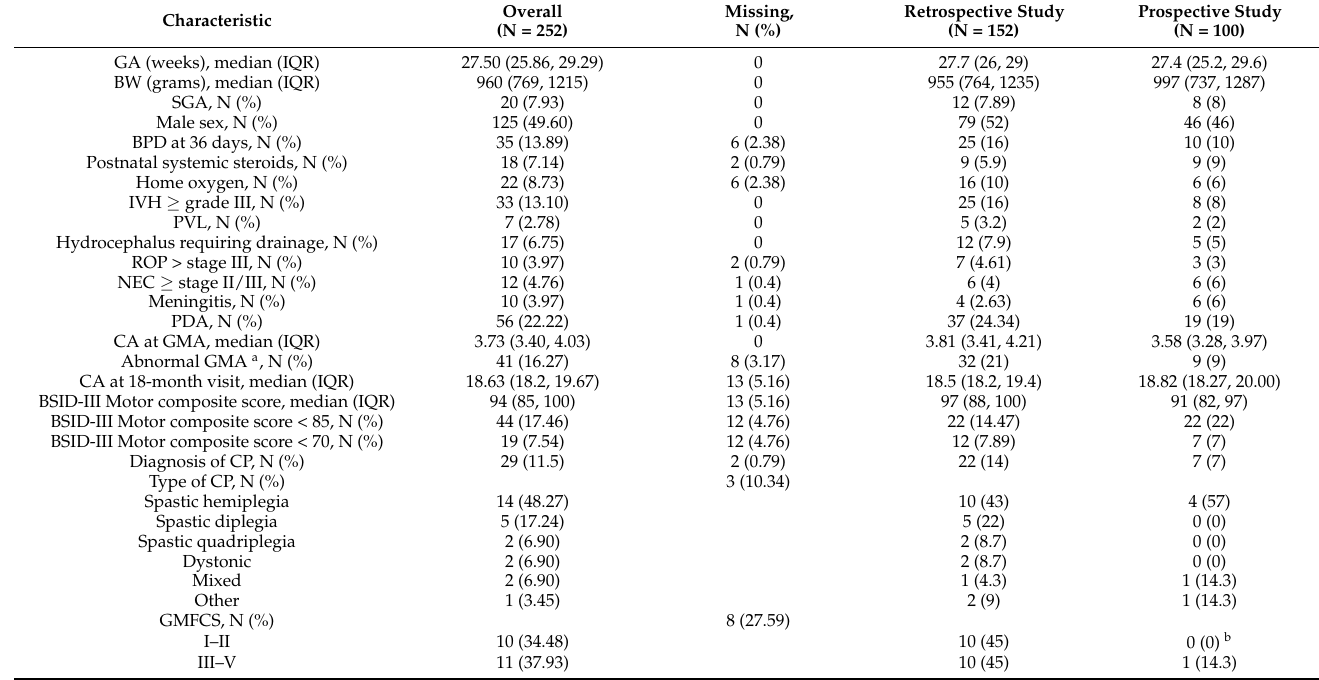
Table 1. Baseline and follow-up characteristics of study population.